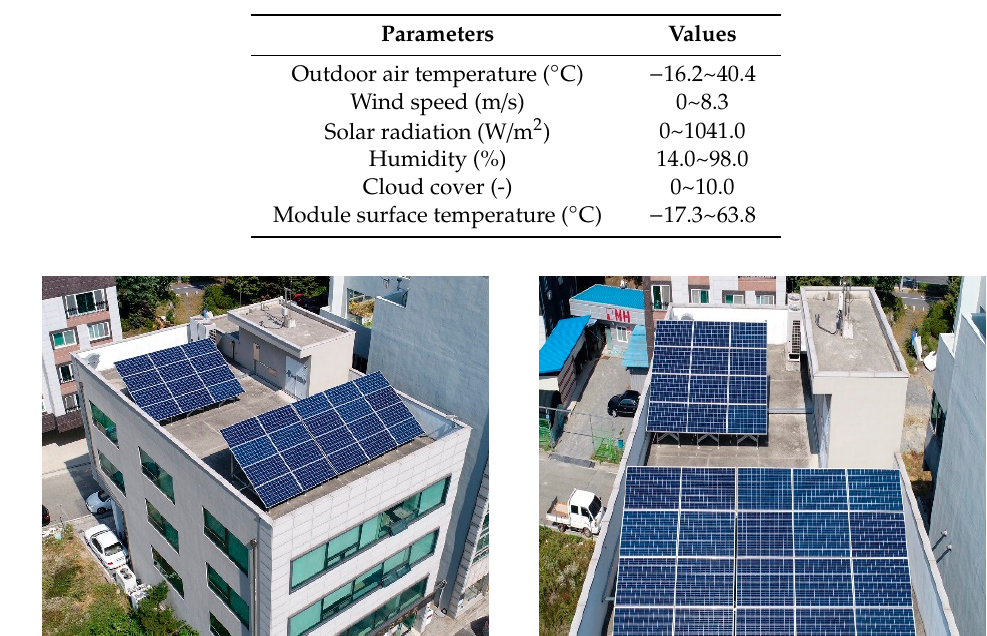
Table 2. Dataset parameters and value ranges.